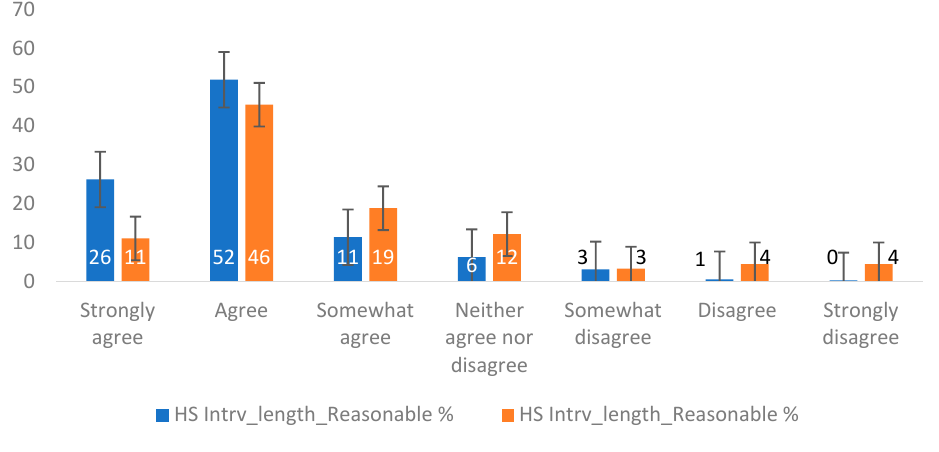
Figure 15. Reasonable Interview Duration.